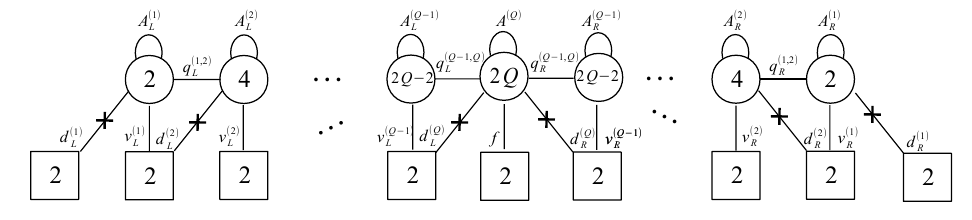
Figure 8: Fields appearing in the lhs of the braid